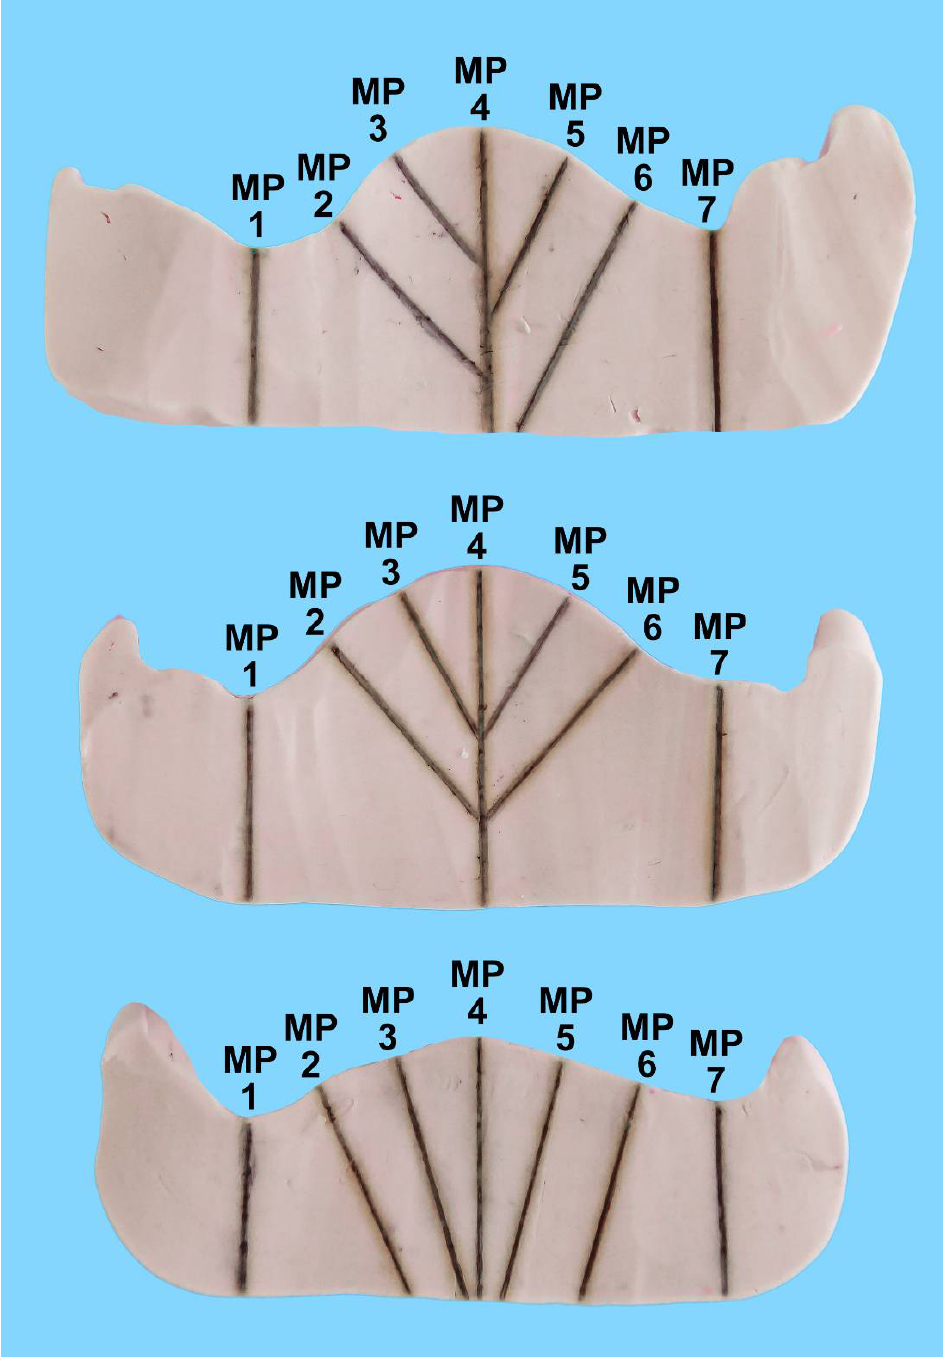
Figure 2. Templates for transferring the measuring points to the three samples (high, medium und flat palates). The templates were fabricated on the master casts and served to accommodate the silicone bloc with the light-body layer detached from the prosthesis (from Figure 3).